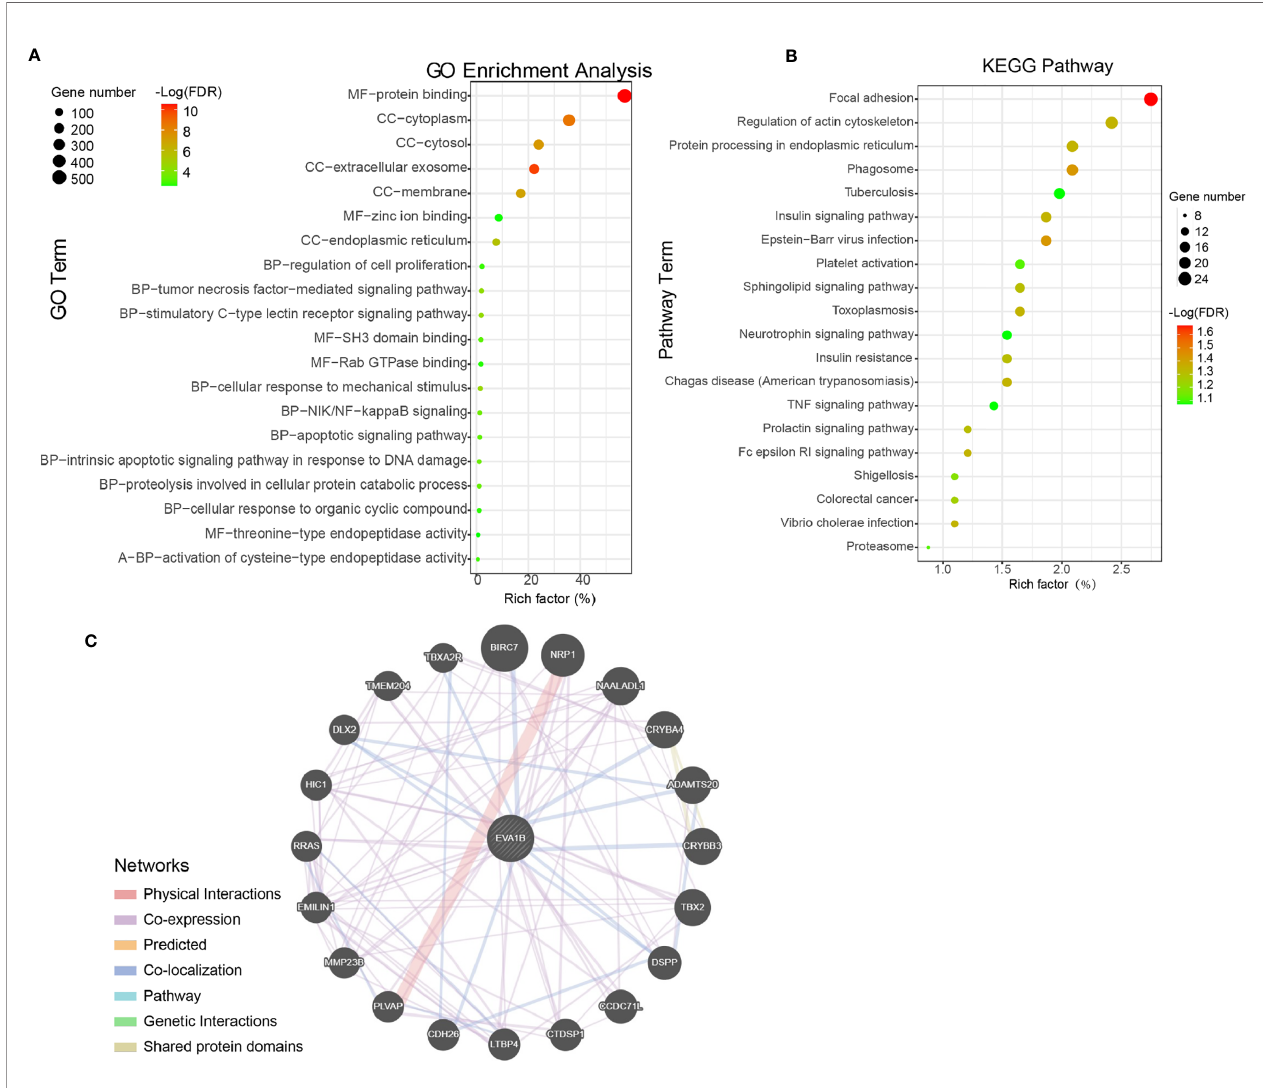
FIGURE 5 | Protein annotation and protein-protein interaction analysis of EVA1B gene in glioma. (A, B) GO and KEGG pathway analysis of EVA1B in glioma. (C) Predicted structural proteins essential for the functioning of EVA1B generated from GeneMANIA. The different colors of the connecting lines represent the physical interactions, co-expression, predicted interactions, co-localization, the same pathway, genetic interactions, and shared protein